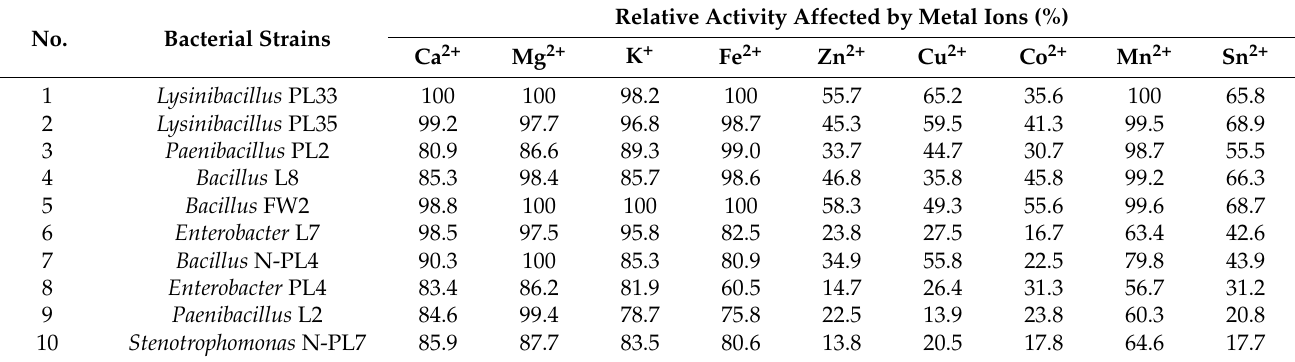
Table 2. Effect of metal ions on lipase activity of bacterial strains examined at 30 °C for 1 h. No.